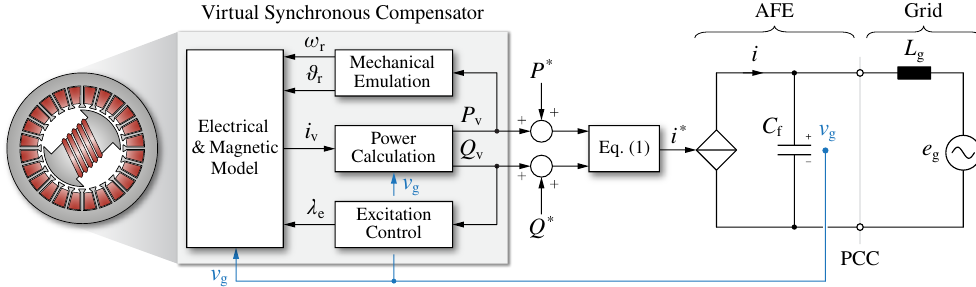
Figure 7. Equivalent block diagram of the proposed S-VSC embedded into the AFE control.